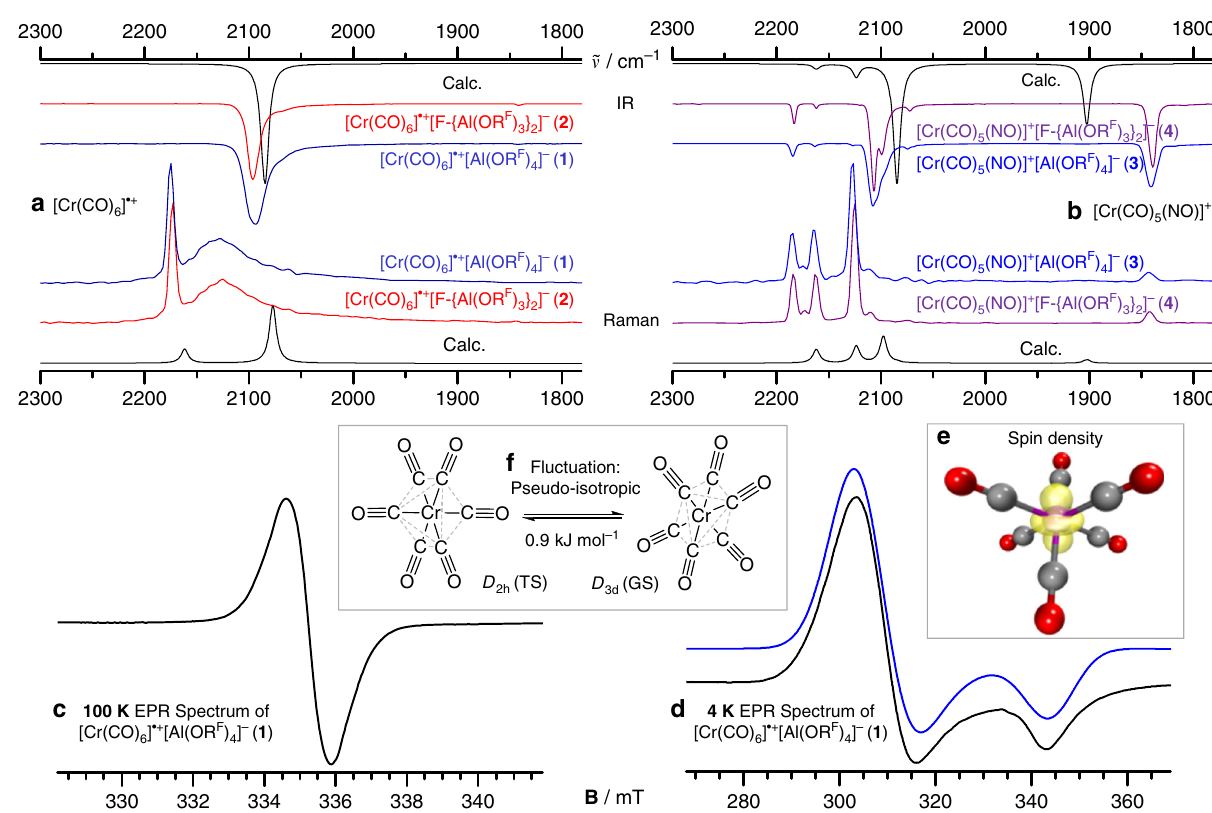
Fig. 2 Block fi gure showing essential IR, Raman, and EPR spectra of complexes 1 – 4 . a , b Stacked IR and Raman spectra of compounds 1 (dark blue), 2 (red), 3 (blue), 4 (purple), and the respective simulated calculated spectra (black, BP86-D3BJ/def2-TZVPP) of the cations in the CO/NO stretching range between 1800 and 2300 cm − 1 ; For the full spectra, including an assignment of all bands see Supplementary Figures 42 – 49 and Supplementary Tables 2, 3. c EPR spectrum of 1 at X-Band (9.4002 GHz) in a frozen solution of a 1:1 (v:v) mixture of o DFB and toluene at 100 K. d Experimental (black) and simulated (blue) EPR spectrum of 1 at X-Band (9.37821 GHz) in a frozen solution of o DFB at 4 K in agreement with the D 3d ground state. e Calculated spin density of D 3d -[Cr(CO) 6 ] (cid:129) + at the SA-CASSCF/cc-pVTZ level of theory. Isovalue at 0.02 a.u. f Equilibration path that transforms the two equivalent D 3d ground states (GS) at 100 K over a low-lying D 2h transition state (TS), yielding a coalescent signal in the 100 K EPR spectrum